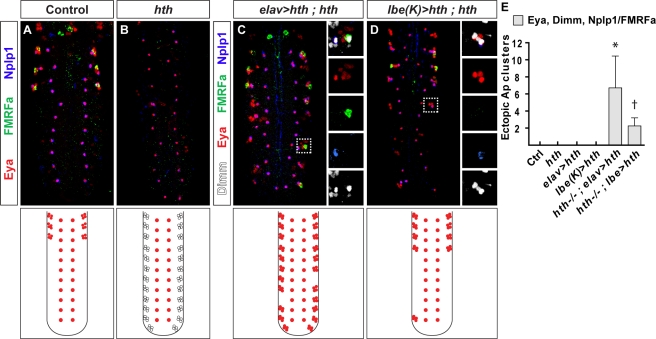
Rescue of homothorax at different time points reveals its dual role.(A and B) Control and hth VNCs reveal the loss of differentiated Ap cluster neurons in hth mutants. However, as shown above, in hth mutants, Ap cluster cells are still present in NB 5-6T. In the abdomen, hth mutants fail to truncate the NB 5-6A lineage, resulting in the appearance of Ap cluster cells. (C and D) Rescue of hth using a late (C) and an early (D) Gal4 driver reveals the dual role of hth. Small boxes show the expression of Eya, Nplp1, and proFMRFa in separate panels. (C) Late expression allows for hth to play its late role in Ap cluster neuron specification, and Ap clusters appear in the majority of abdominal segments, evident by the expression of Eya, Nplp1, and FMRFa. However, using this Gal4 driver, hth is reintroduced too late to truncate the NB 5-6A lineage. (D) In contrast, early expression of hth reintroduces hth early enough to truncate the NB 5-6A lineage, evident by fewer Ap clusters in the abdomen. In addition, in the thoracic segments, hth still can play its late role—specifying Ap cluster neurons—evident by the reappearance of Ap clusters in thoracic segments. (E) Quantification of Ap clusters, defined as the presence of Eya, Dimm, and at least one of the two neuropeptides FMRFa and Nplp1 in abdominal lateral segments (abdominal Ap clusters/VNC; n>7). Asterisk denotes significant difference compared to control, † denotes significant difference compared to elav>hth; hth−/− (p<0.01; Student two-tailed test). Genotypes: (A) w1118. (B) hth5E04/hthDf3R. (C) UAS-hth/+; elav-Gal4,hth5E04/hthDf3R. (D) lbe(K)-Gal4/UAS-hth;hth5E04/hthDf3R.